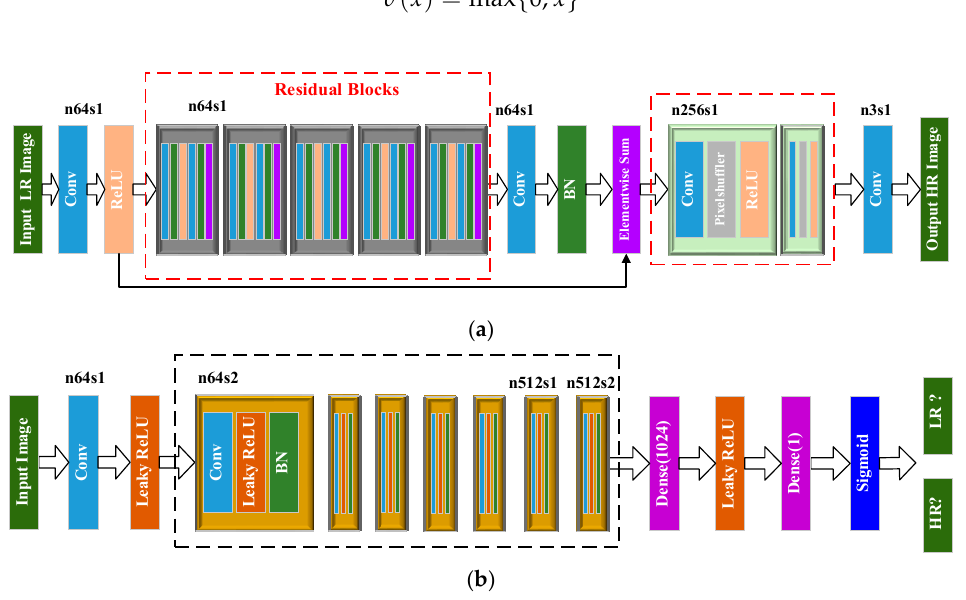
Figure 2. Architecture of SRGAN (“n” is the no. of feature maps, “s” is the stride of each convolutional layer): ( a ) generator, and ( b ) Discriminator.